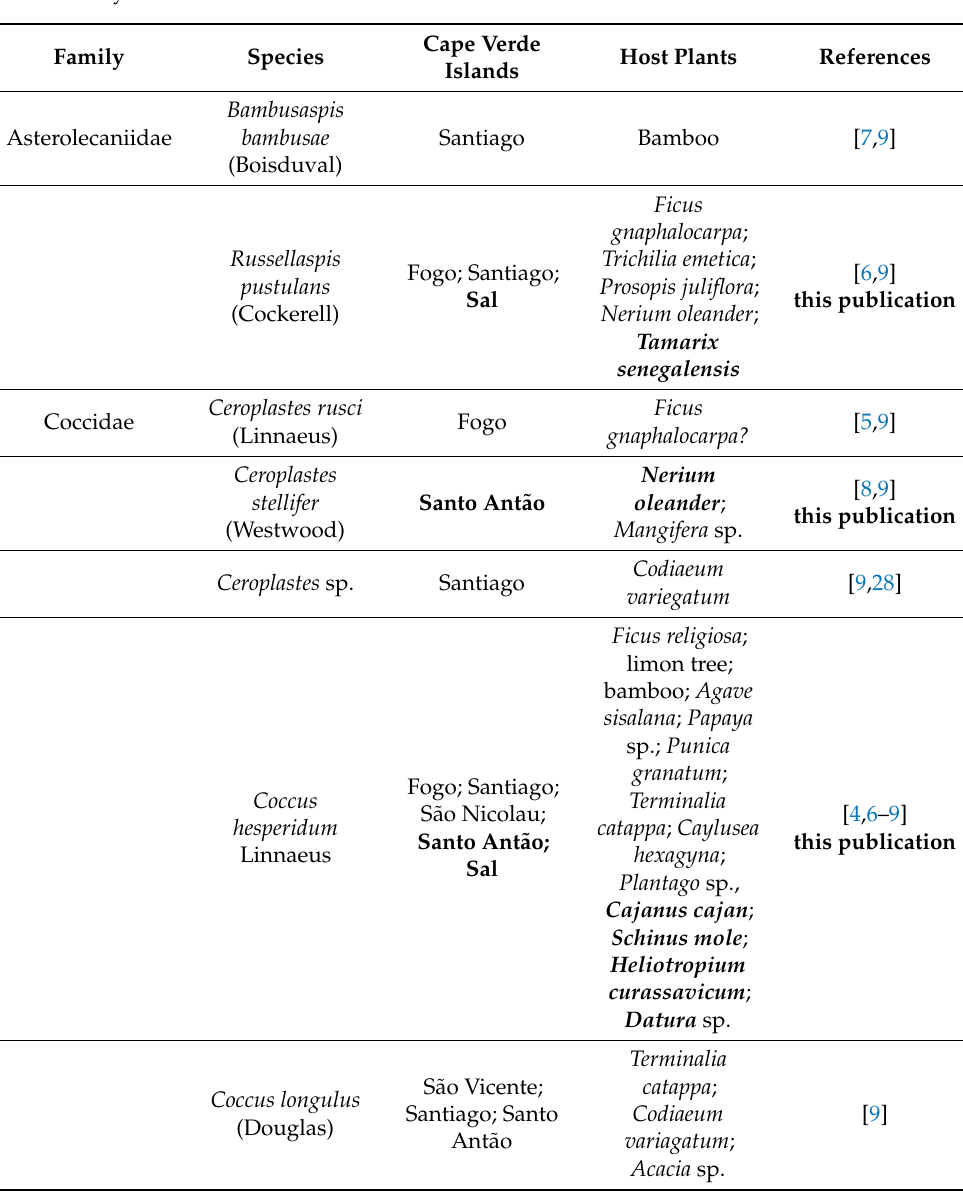
Table 1. Checklist of scale insect species from the Cape Verde archipelago. All records from the present study are included in